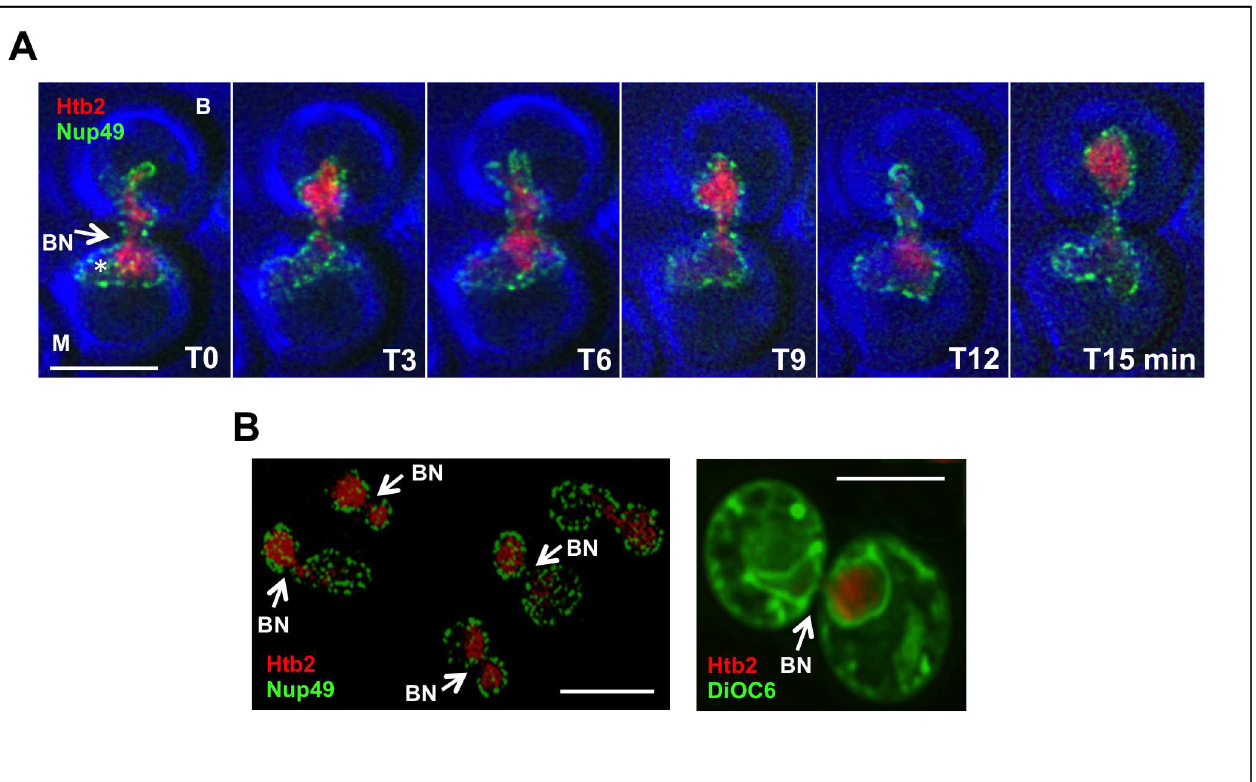
Fig 1. Organization of the Nuclear Envelope in Arrested Cells. (A) Dynamics of the nuclear envelope:Time-lapse images of a MET3-CDC20 strain expressingHtb2-mRFP and Nup49-GFP, after additionof methionine for 4 hours to depleteCdc20. Note that the NE extends approximately equallyinto the mother and bud at all time points. The star ( * ) indicatesa regionof the nucleoplasm that is occupiedby the nucleolus, judgingfrom examination of other arrested strains. M and B designatethe mother and bud domainsrespectively. In these and all other images, the scale bar is 5 microns. Unless indicatedto the contrary, all images are projectionsof 5–10 Z-sections. In this figure and all others, the bud neck is designatedas BN. Strain: ATY4435. (B) The bud neck: Distributionof Nup49-GFP. A MET3-CDC20 strain expressingHtb2-mRFP and Nup49-GFP was arrested for 4 hr. The arrows indicate the frequent absenceof Nup49-GFP from the bud neck. Strain: ATY4435.Exclusionof DiOC6 from the bud neck. A petite MET3-CDC20 strain expressingHtb2-mRFP was arrested and stainedwith DiOC6 to detect lipidsof the ER (and possiblyother membranes [17]). Note the near-absence of signal at the bud neck. This image is from a single 0.5 micron Z-section. Strain: ATY4435.